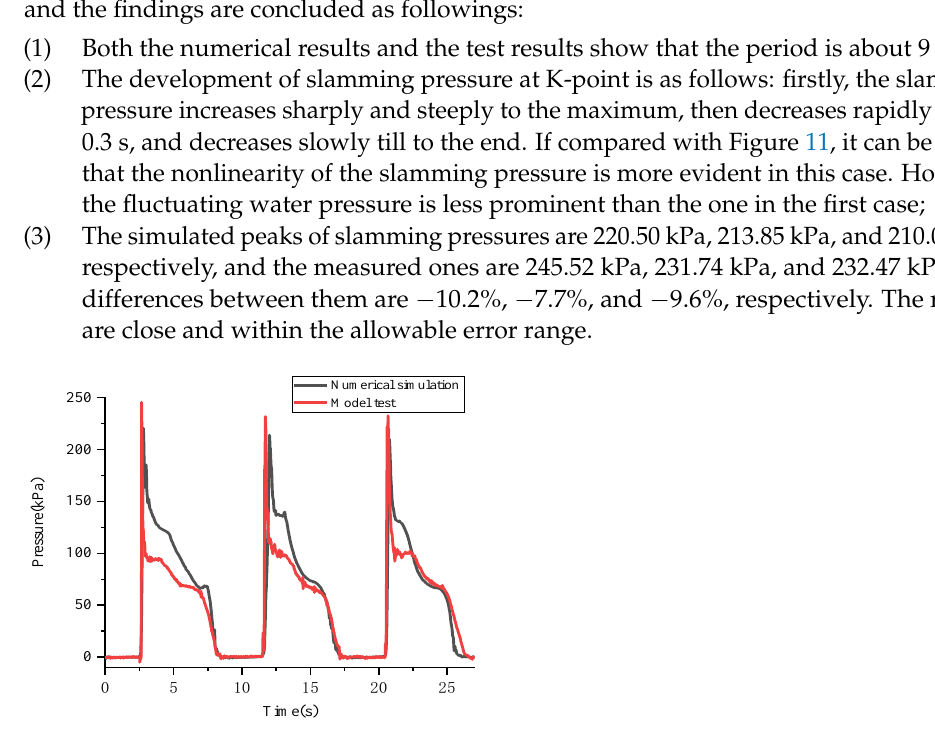
Figure 12. Comparison of K-point slamming pressure under the wave condition with H = 15 m, T = 9 s.